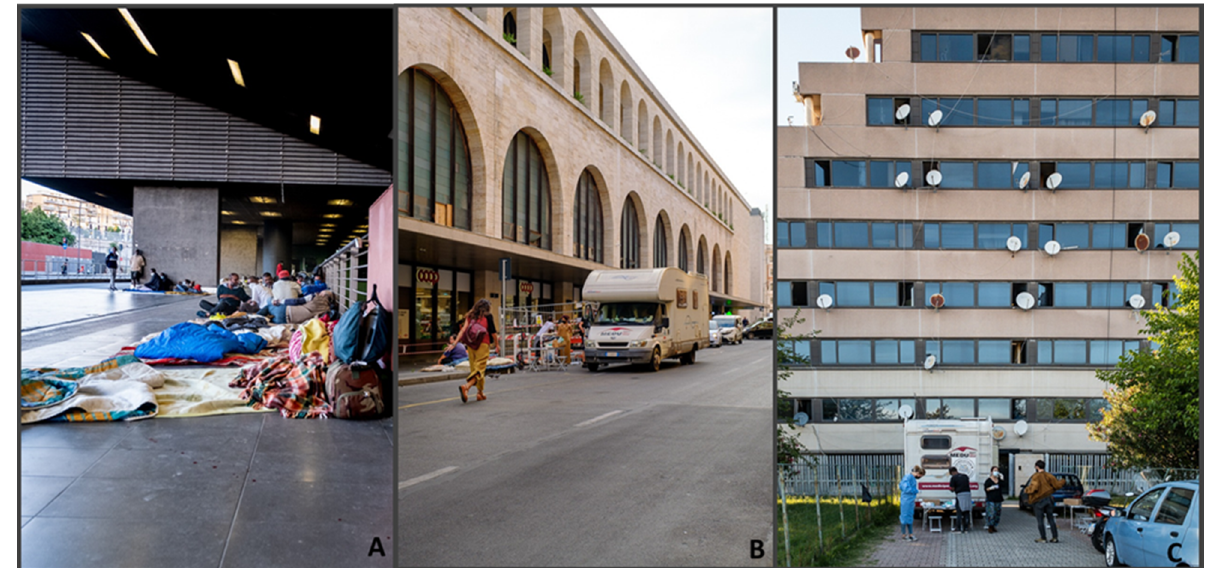
Figure 1. Study area: informal settlement of Rome: ( A ) Tiburtina station, homeless migrants living near the station entrance; ( B ) Termini station, MEDU’s mobile clinic parked near the station during the weekly assistance activities; ( C ) Collatina’s settlement, MEDU’s staff positioned at the foot of the building just before the weekly assistance activity. Photographs by Odino Vignali.